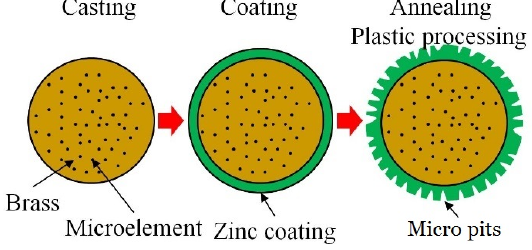
Figure 2. The preparation process of the ZCSMWE.